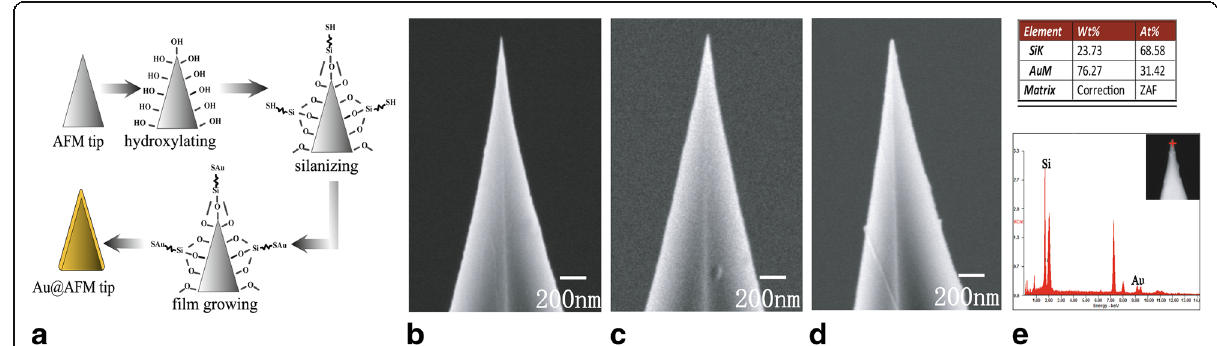
Fig. 1 a Illustration of the wet-chemical procedure for preparing an AFM-based tip-enhanced Raman spectroscopy (AFM-TERS) probe. b A commercial Si AFM probe with the apex size < 15 nm. c Silanized probe with the apex diameter of ~ 20 nm. d Au@AFM probe after a 5 min immersion and apex diameter of 25 nm. e Energy dispersive spectrometer (EDS) of the probe in